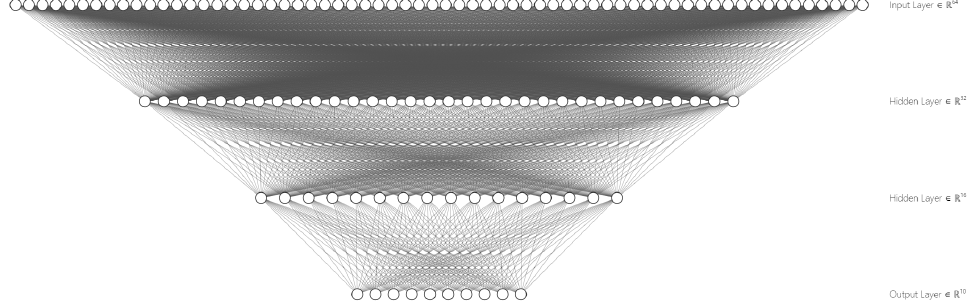
Figure 6. Graphical representation of the MLP neural network of scenario